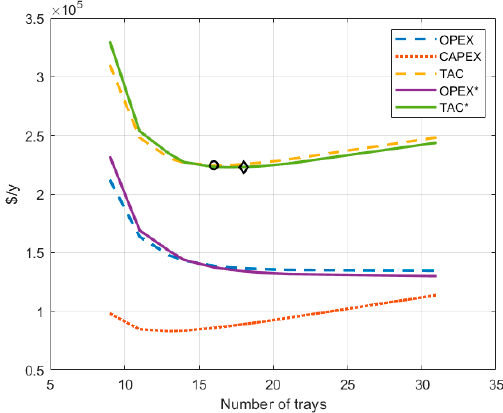
Figure 8. Distillation TAC under uncertain operating conditions (Gamma PDF).